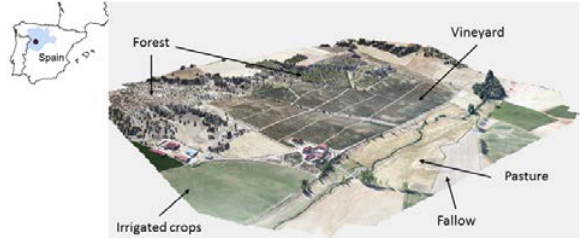
Figure 1. Location of the study area and land use map.